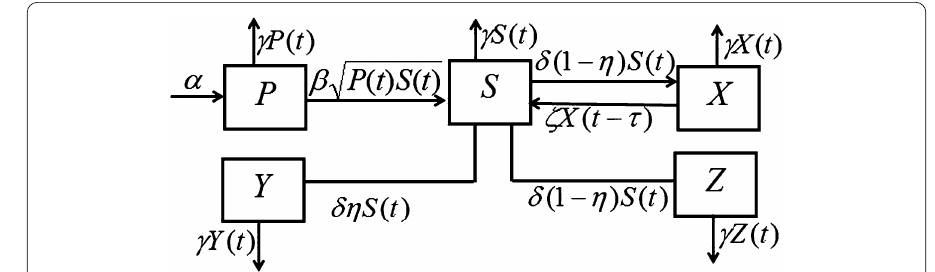
Figure 1 The flow diagram of system